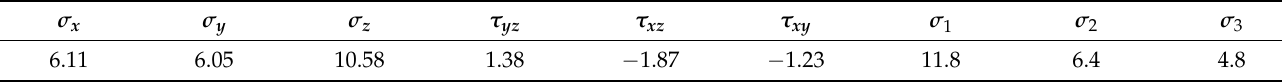
Table 2. The obtained in situ stress state (unit: